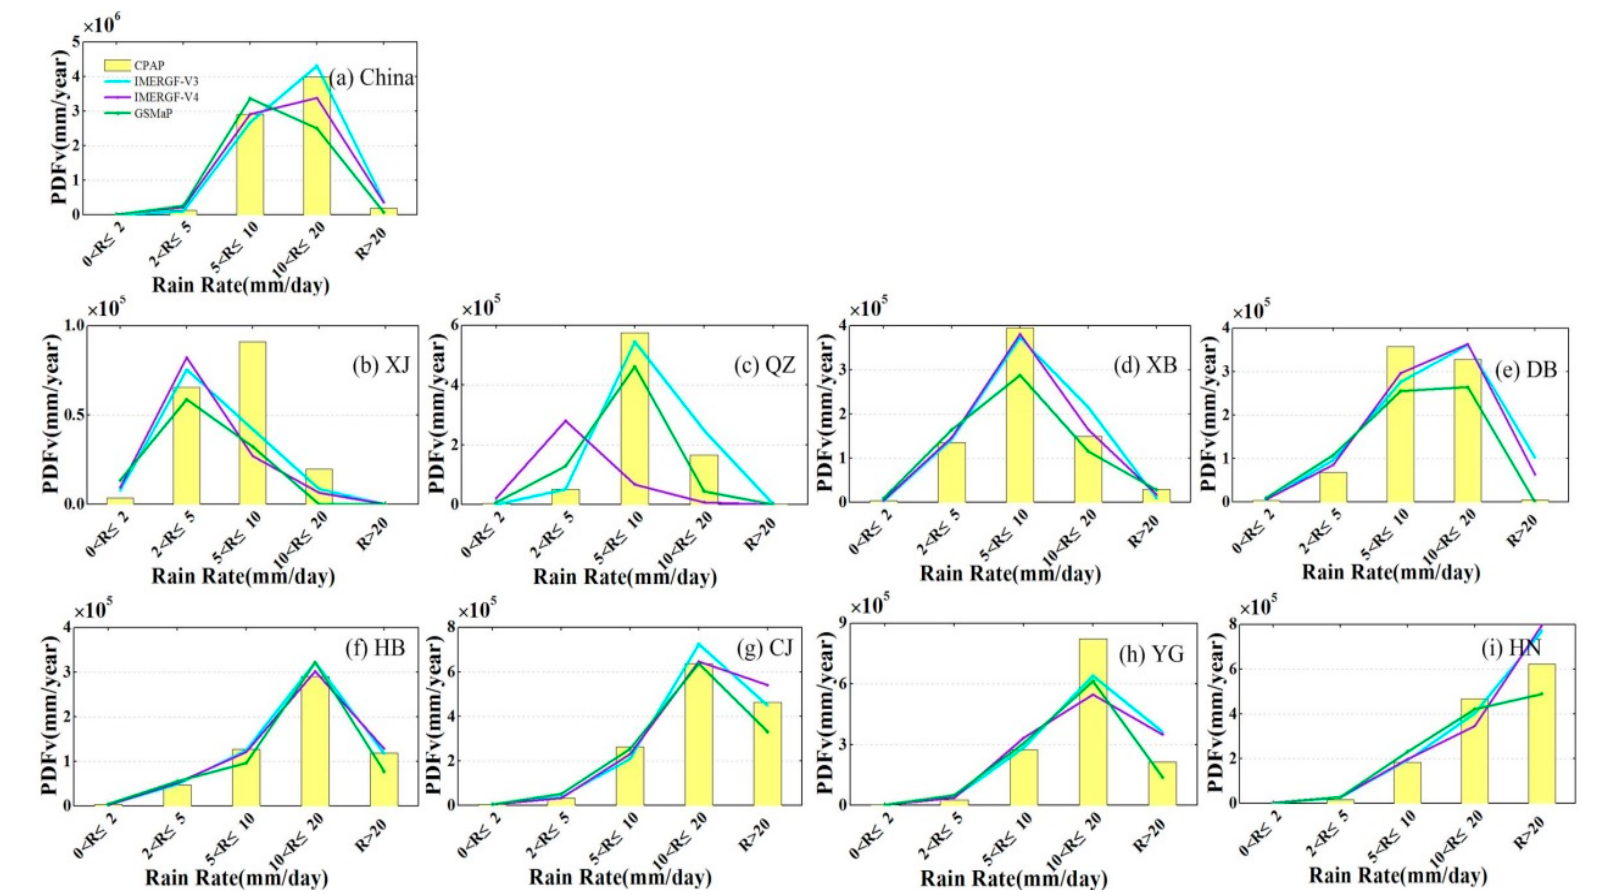
Figure 8. PDFv of daily rainfall for specific rainfall intensity bins over mainland China and eight sub-regions from March 2014 to February 2015. ( a ) represents the PDFv over China and ( b – i ) represents the PDFv distributions over eight sub-regions, respectively.